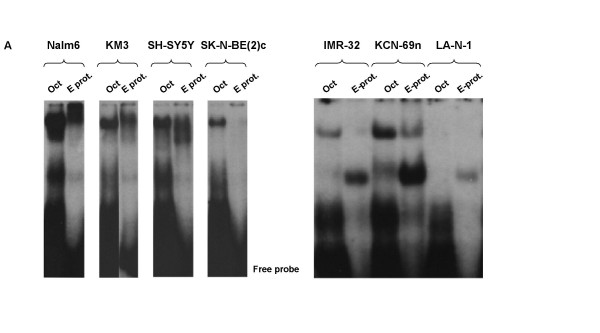
Neuroblastoma cells express variable levels of E-protein activity.  Panel (A) display auto radiograms with EMSAs of Oct and ?E-5 (E-protein) DNA  binding activity in nuclear extracts from Nalm6 and KM3 pre-B lymphoma cells  and SH-SY5Y, SK-N-BE(2)c, IMR-32, KCN-69n and LA-N-1 neuroblastoma cells.